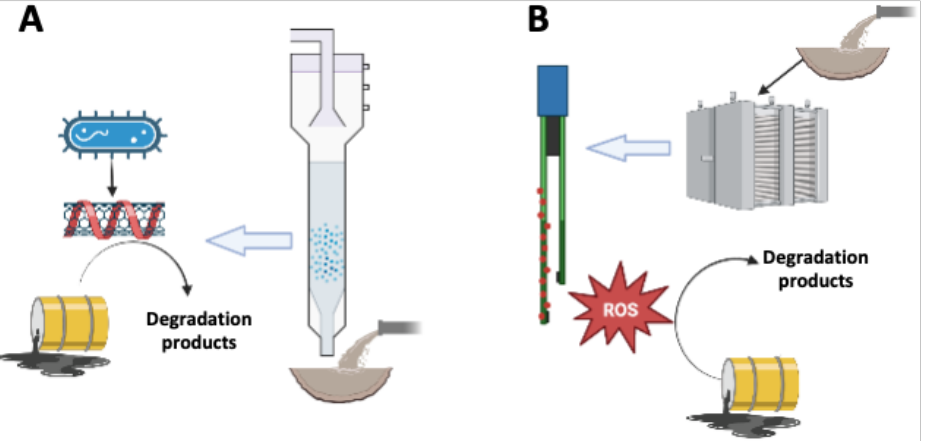
Figure 2. Mechanisms involved in the degradation of recalcitrant pollutants mediated by immobilized NMs in bioprocesses ( A ) and in electrochemical systems ( B ). Bacteria reduce conductive NMs (e.g., nanotubes), which promote redox reactions driving the biodegradation of contaminants ( A ). Immobilized NMs in electrochemical systems produce reactive oxygen species (ROS), which stimulate the degradation of contaminants ( B ).